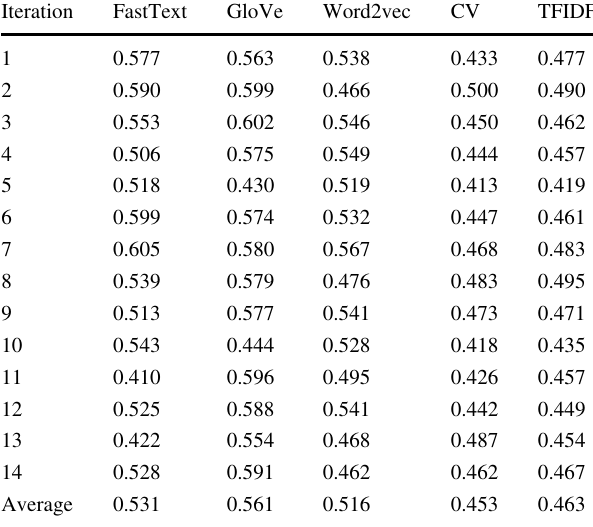
Table 3 Silhouette coefficient of various